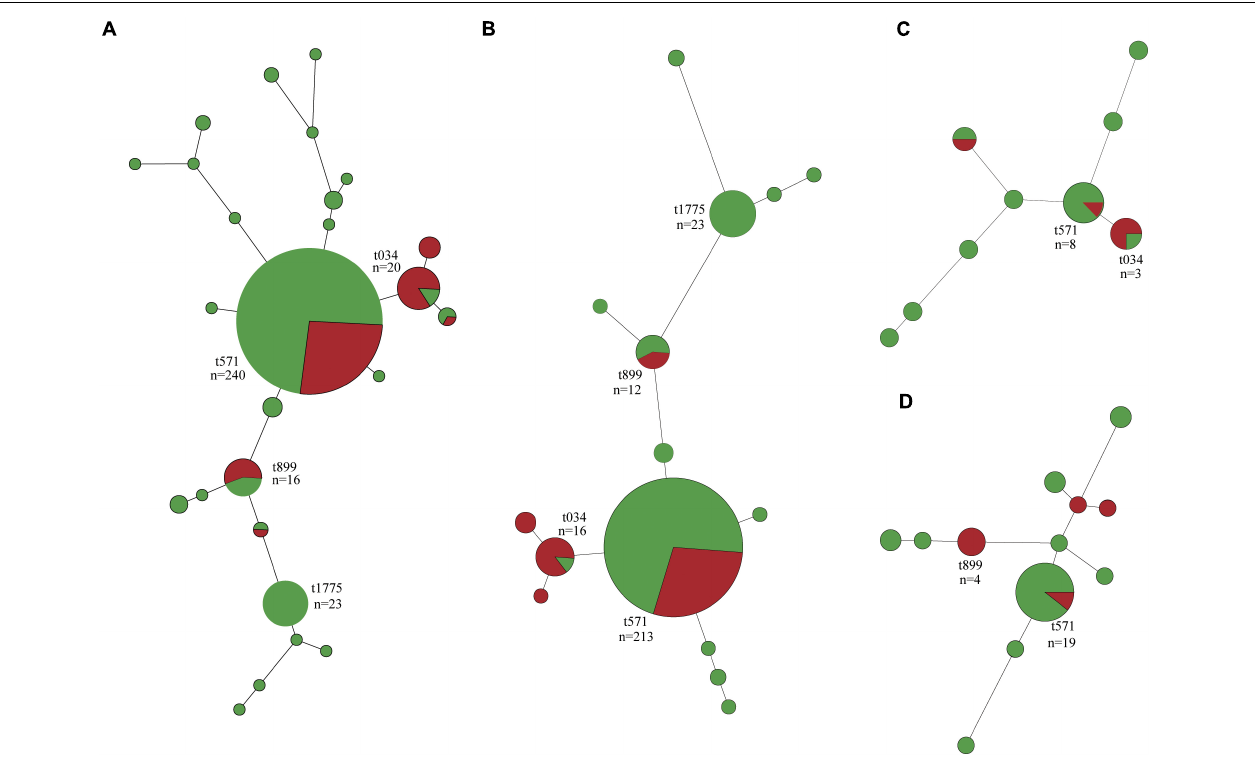
FIGURE 2 | Minimum spanning tree of methicillin-susceptible Staphylococcus aureus (MSSA, n = 243) and methicillin-resistant S. aureus (MRSA, n = 97) isolates by spa type. (A) All isolates. (B) Isolates of swine origin. (C) Isolates of human origin. (D) Isolates of environmental origin. Each node represents a single spa type. The size of the node is proportional to the number of isolates represented by a said node. Branch lengths between nodes are proportional to the number of alleles that differ between the two linked nodes. Selected nodes are labeled with corresponding spa type and number of isolates represented. Red nodes, MRSA; green nodes,